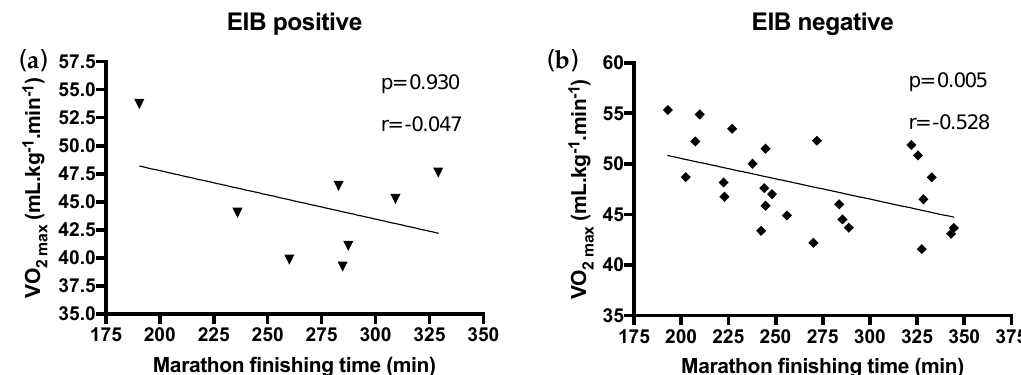
Figure 4. Correlation between aerobic capacity and performance. ( a ): EIB positive; ( b ): EIB negative.